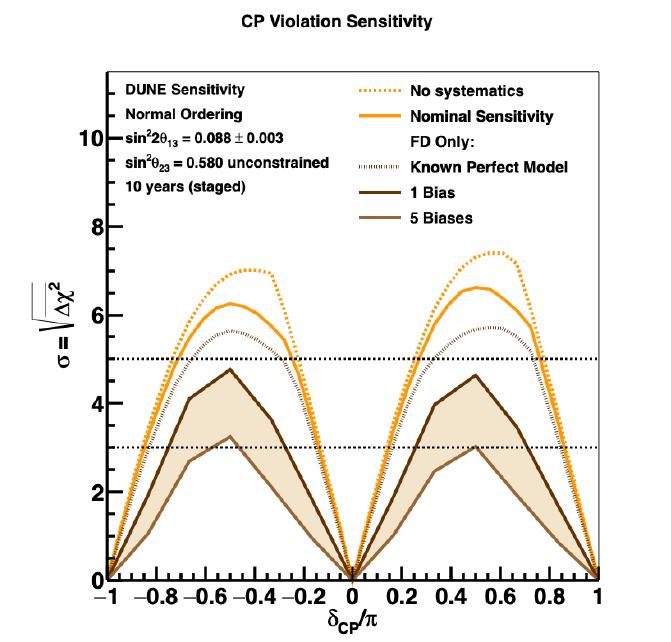
Figure 143. Effect on DUNE’s sensitivity to the CP-violating phase if an incorrect cross section model is used in the reconstruction. This illustrates the danger of not improving/tuning the cross section model using data taken with the